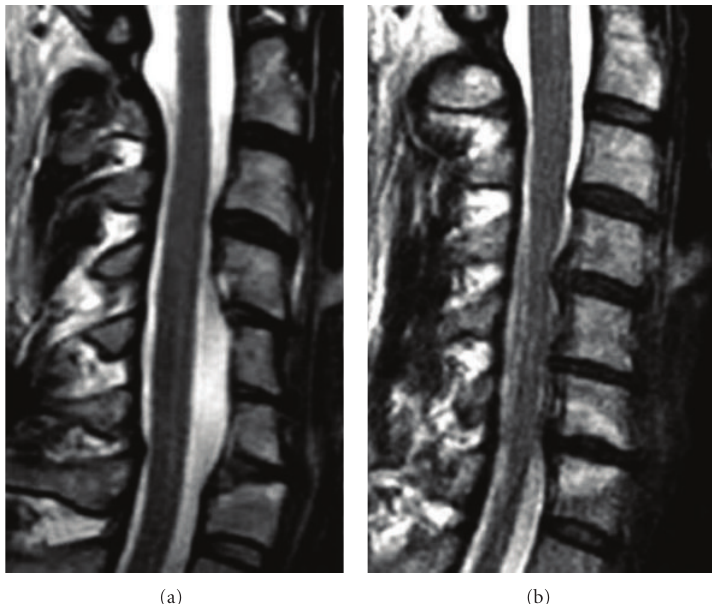
Figure 6: (b) Preoperative T2-weighted sagittal MRI showing spinal cord compression at the C4-C5, C5-C6, and C6-C7 levels. (a) Postoperative T2-weighted sagittal MRI illustrating the wide spinal cord decompression after 2 levels MOC.